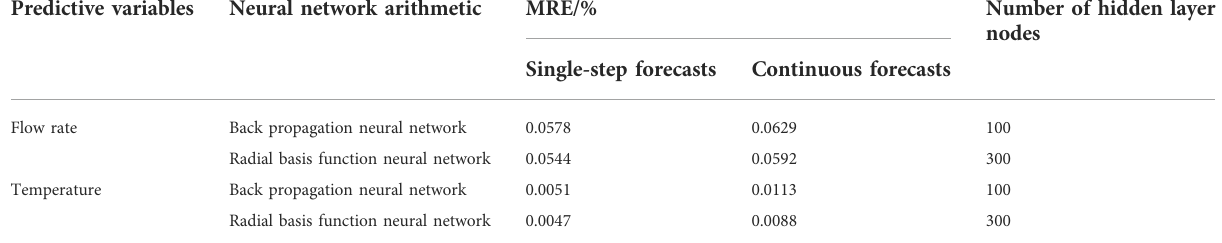
TABLE 3 Comparison of neural network forecasting